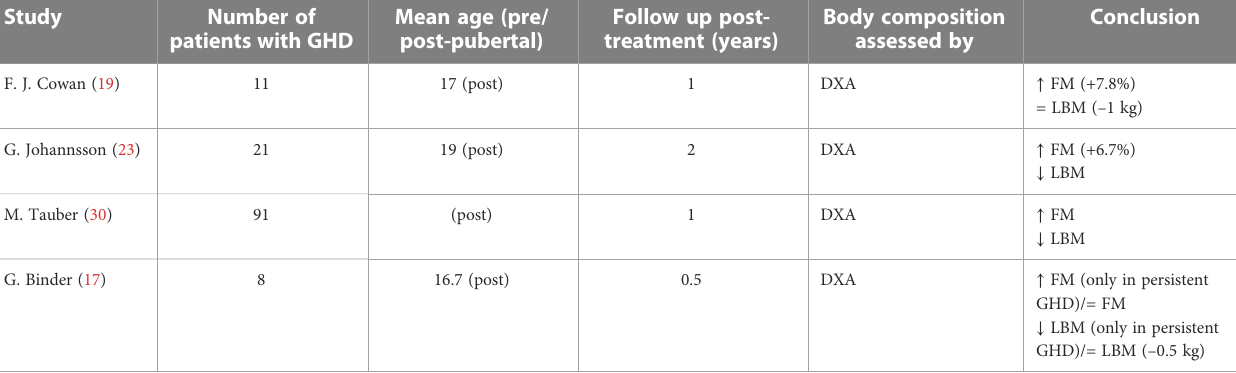
TABLE 2 Studies that evaluated body composition after rhGH treatment suspension in children with GHD. Study